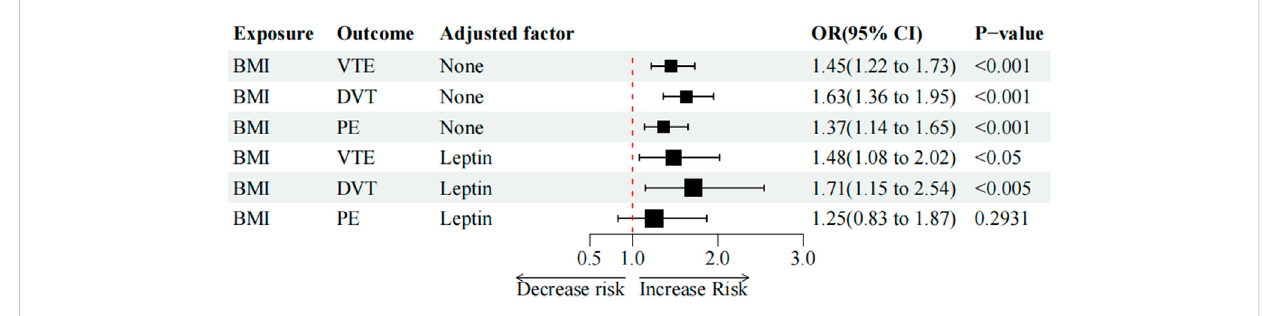
FIGURE 3 Multivariate MR analysis of BMI on VTE, DVT, and